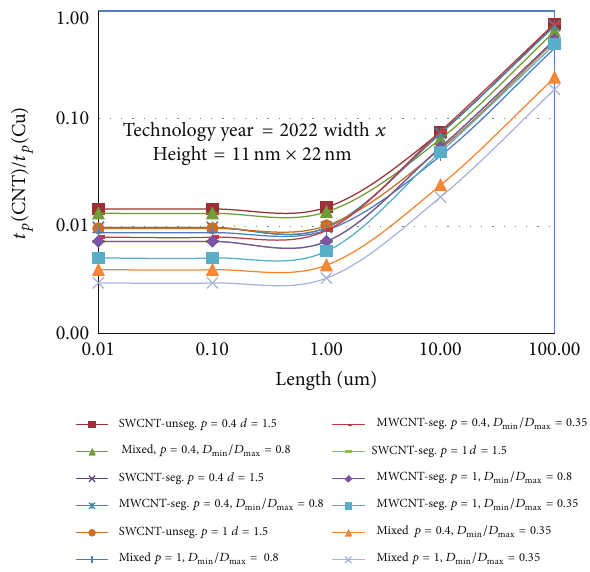
Figure 3: Ratio of propagation delay of CNT bundles with copper.